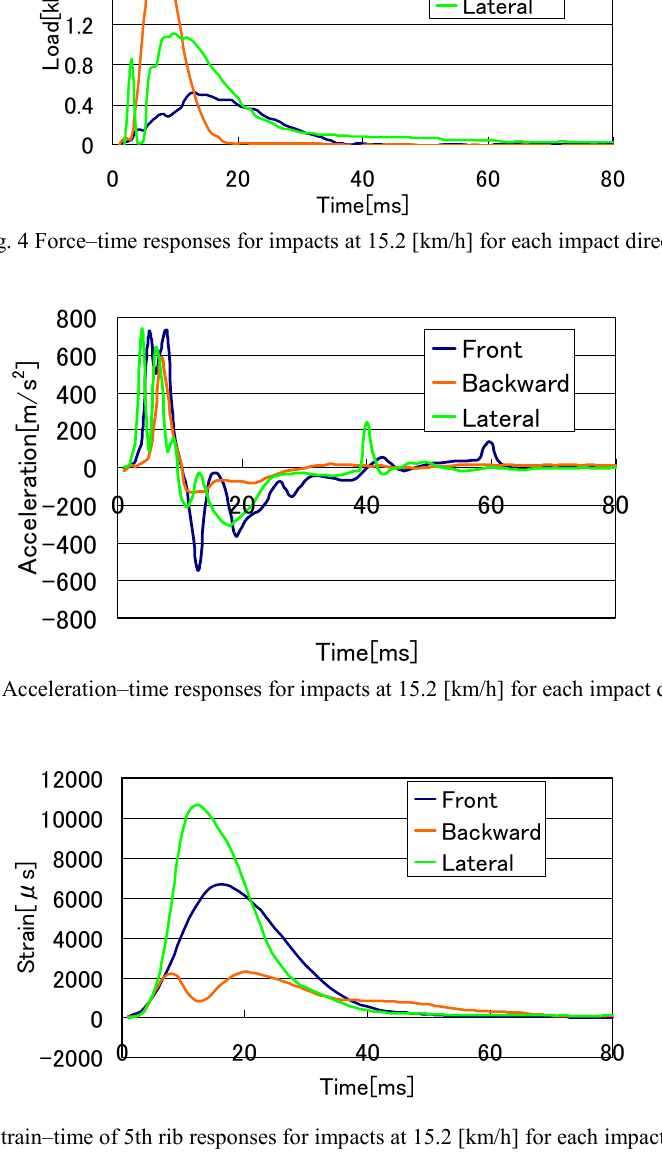
Fig. 6 Strain–time of 5th rib responses for impacts at 15.2 [km/h] for each impact